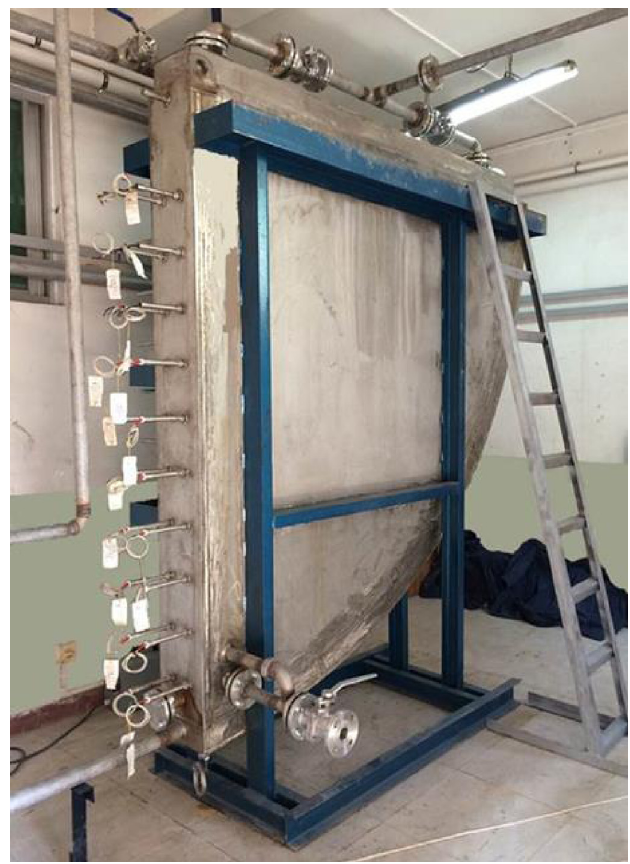
Fig. 2. Test vessel of the COPRA chinese facility in XJTU (@XJTU,